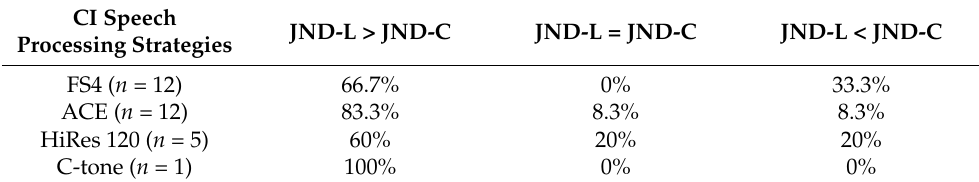
Table 2. Percentage of the children with CIs exhibiting different patterns of JNDs of F0 level (JND-L) and F0 contour (JND-C) change regarding each type of speech processing